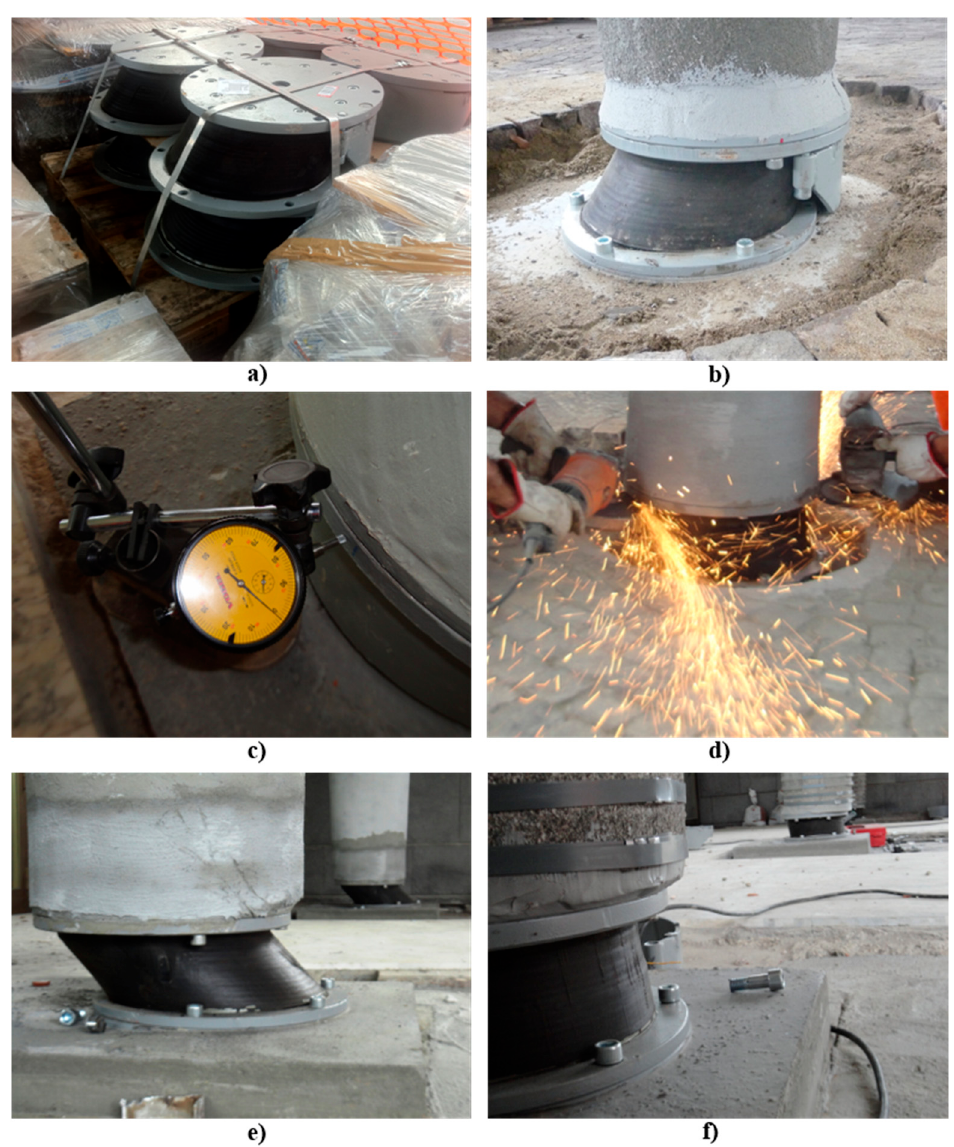
Figure 14. Some pictures of the pre-deformed LRB isolators: ( a ) storage of the devices at the construction yard; ( b ) pre-deformed LRB installed under the column; ( c ) installation of the high precision displacement transducer; ( d ) removal of the temporary constraint; LRB device at ( e ) the beginning, and at ( f ) the end of the re-centering operations.